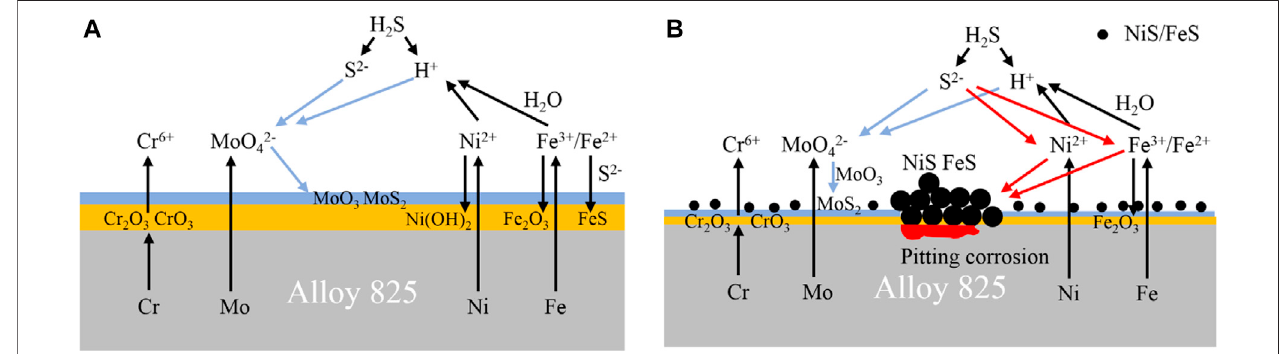
FIGURE 8 | The possible corrosion mechanism of Alloy 825 (A) 150 ° C (B) 230 ° C.